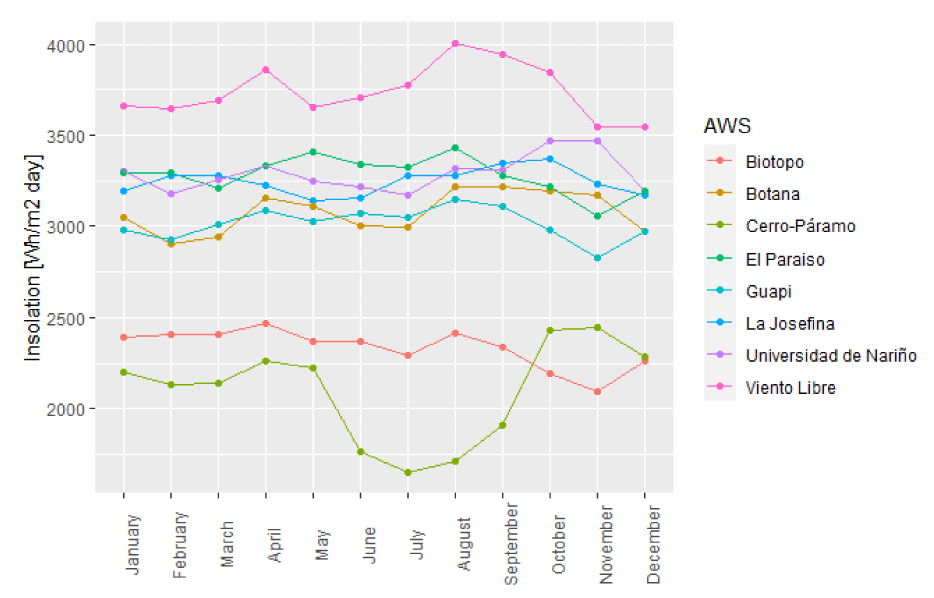
Figure 20. Daily monthly